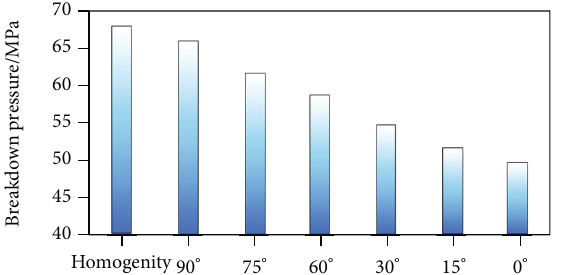
Figure 13: Fracture propagation with di ff erent dip angles of bedding plane [55]. Table 3: Strength parameters of the bedding plane.